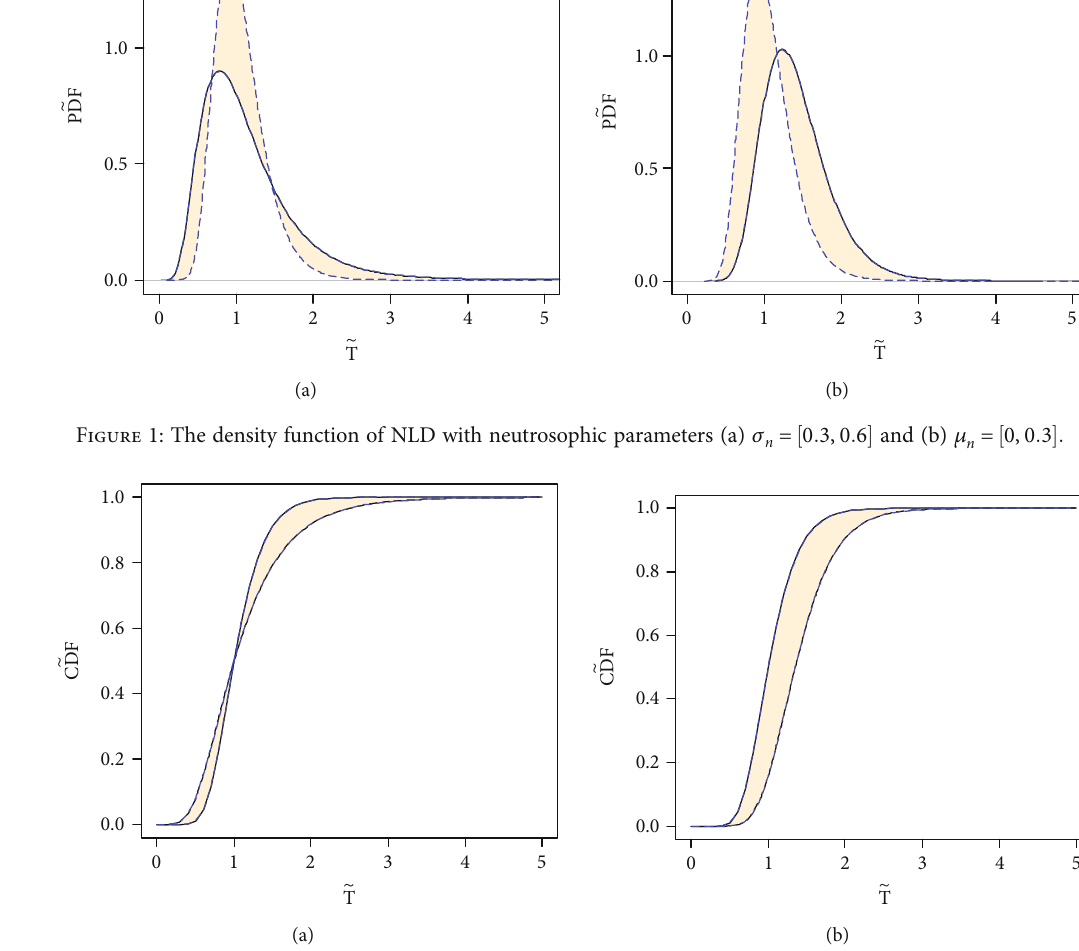
Figure 2: The g CDF curve for the vague parameter values (a) σ